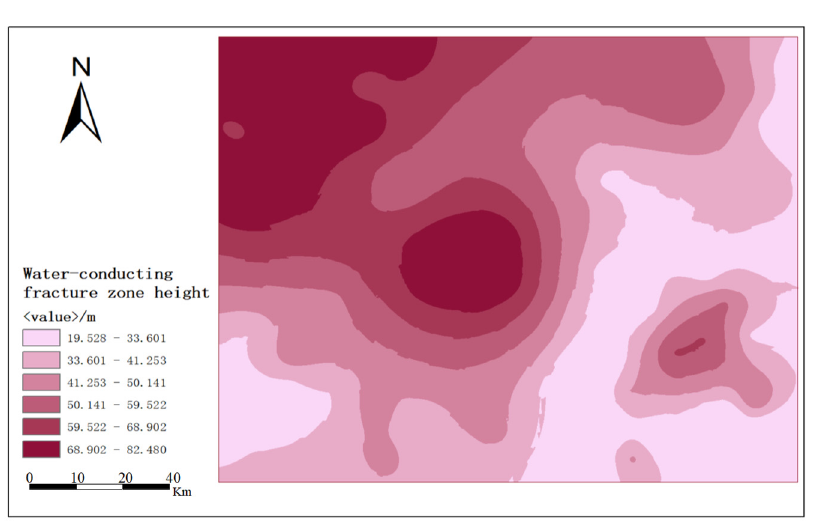
Figure 16. Development height distribution of Yingpanhao water-conducting